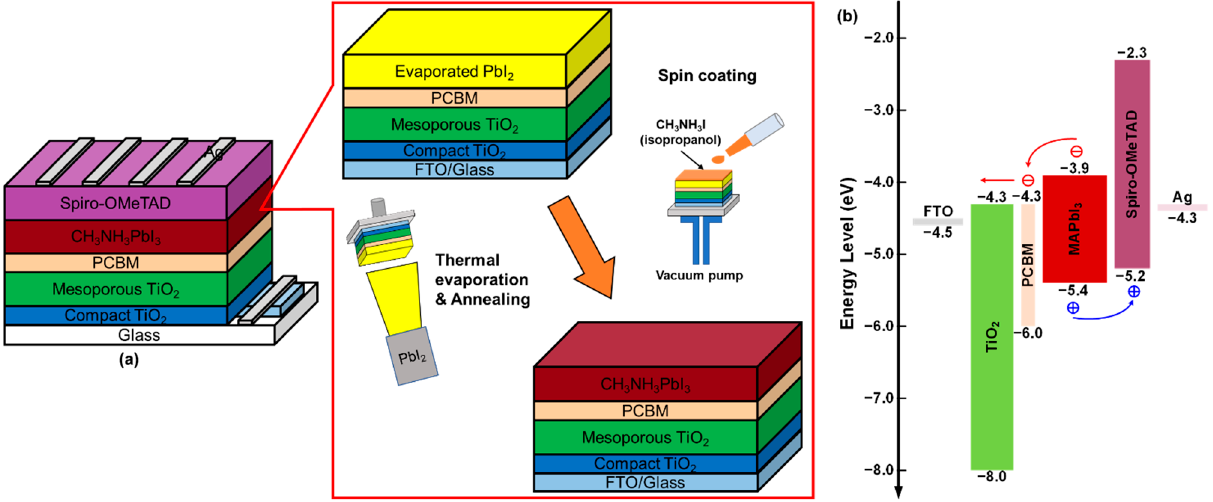
Figure 1. Schematic of the ( a ) perovskite solar cell configuration and ( b ) energy band diagram. The inset shows a schematic representation of the synthesis of the MAPbI 3 perovskite film used to create evaporated PbI 2 in the perovskite